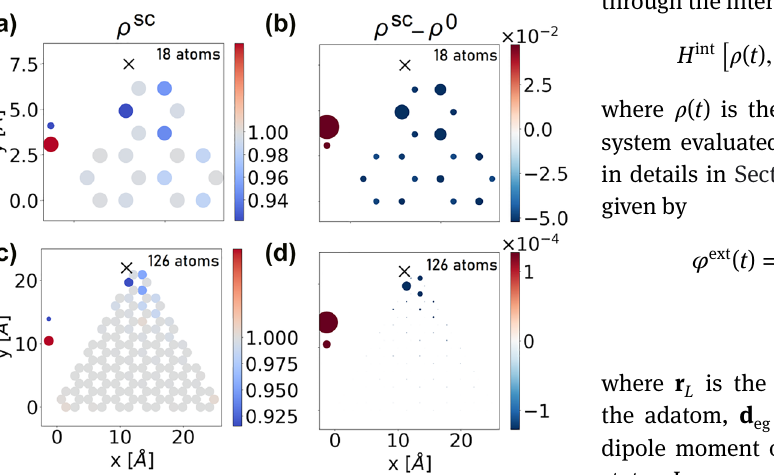
Figure 3: (a and b) Charge distribution on a hybrid system consisting of an armchair triangular graphene flake with 18 atoms and an adatom. The adatom is located near one particular site at a = t = 2.0 eV. The position marked with X and coupled with t e g adatom level energies lie inside the gap around the Fermi level with E e = 0.5 eV and E g = − 0.5 eV. The plots show the real-space charge distribution due to the self-consistent density matrix 𝜌 sc (a), as well as the difference with respect to the density matrix corresponding to a uniform charge distribution 𝜌 sc − 𝜌 0 . (b) The occupation of the adatom levels is presented on the left side of the figure (upper dot denotes the excited state, lower dot – the ground state). (c and d) As in (a and b), but for the flake with 126 atoms. On panels (b and d) the area of the spots is proportional to the density matrix modification . on a given site ( 𝜌 sc − 𝜌 0 ) ll